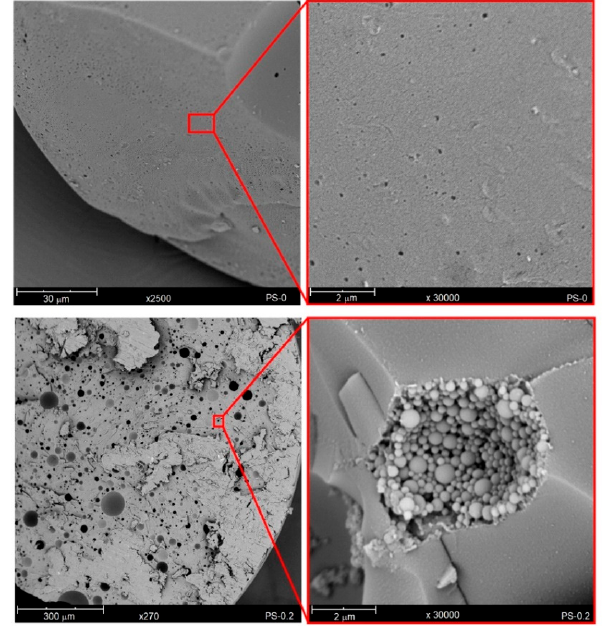
Figure 4. SEM images of cross-section of PS-0 and PS-0.2 nanocomposites.